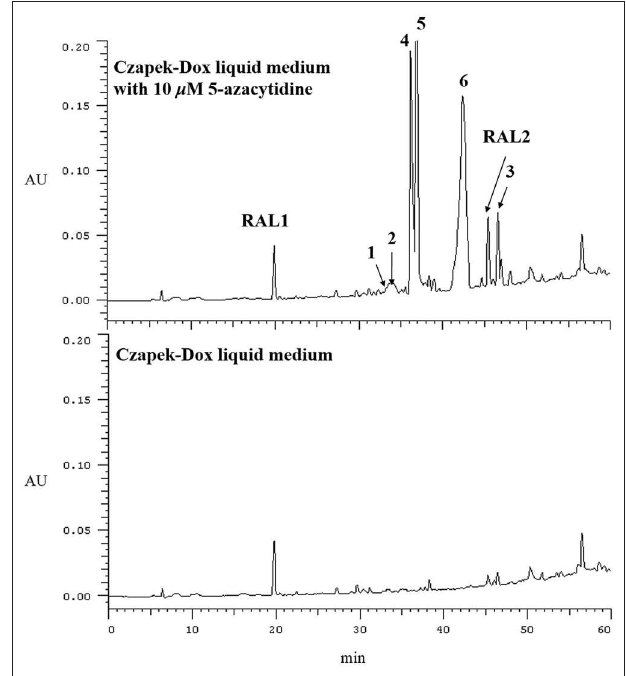
FIGURE 1 | HPLC profiles of EtOAc extracts of C. lunatus (TA26-46) cultured in Czapek-Dox liquid medium with 10 µ M 5-azacytidine.